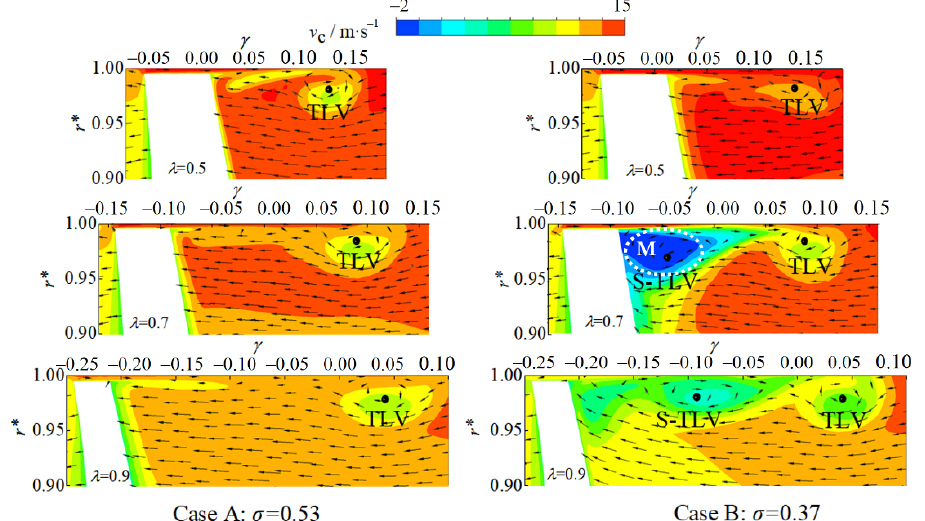
Figure 13. Distributions of circumferential velocity on three planes.